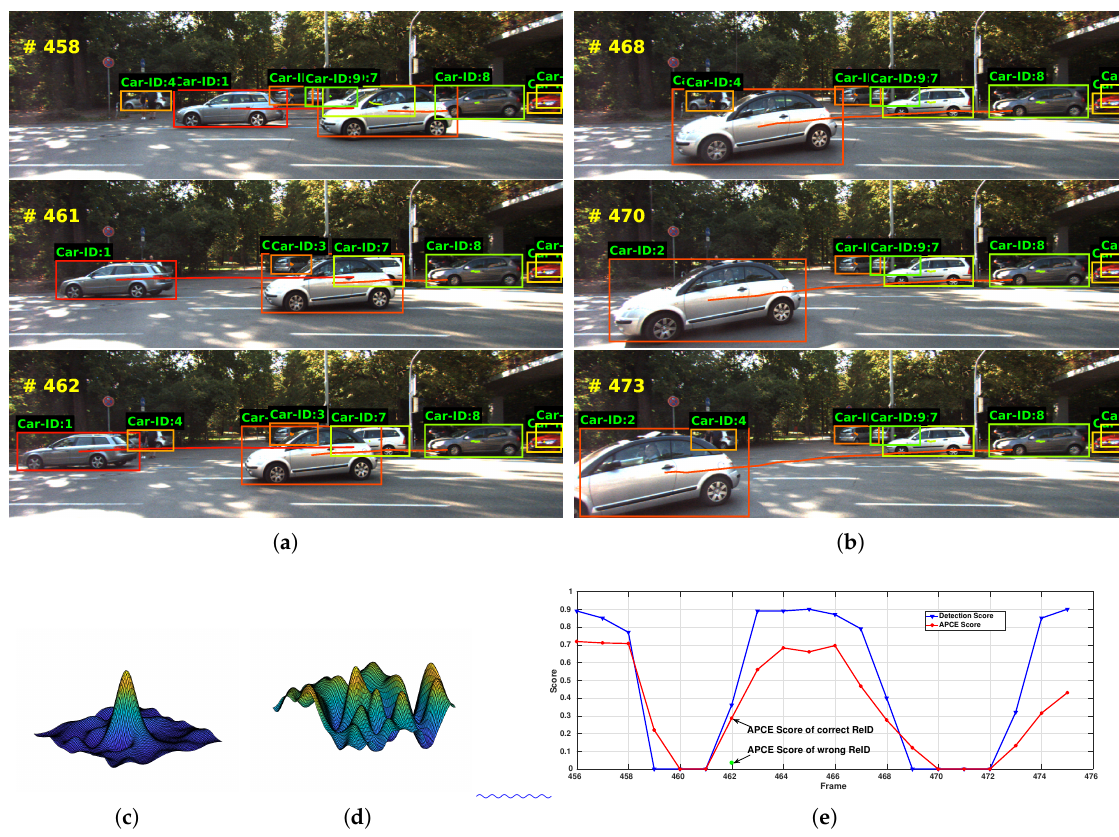
Figure 4. We show the ReID process of our approach using the car of ID-4 as an example. As shown in ( a ), the car ID-4 is firstly detected in frame 458, but then completely occluded in frame 461. After it re-appears again in frame 462, our ReID algorithm correctly recognize it as ID-4. ( b ) also shows an example of the ReID process. Panels ( c , d ) are the response maps of the new detection of ID-4 in frame 462 with two inactive tracklets: ID-4 and ID-9. It is observed that ( c ) has a sharp peak and ( d ) fluctuates intensively. By calculating the APCE score of these two score maps, as shown in ( e ), we correctly assign this new detection to